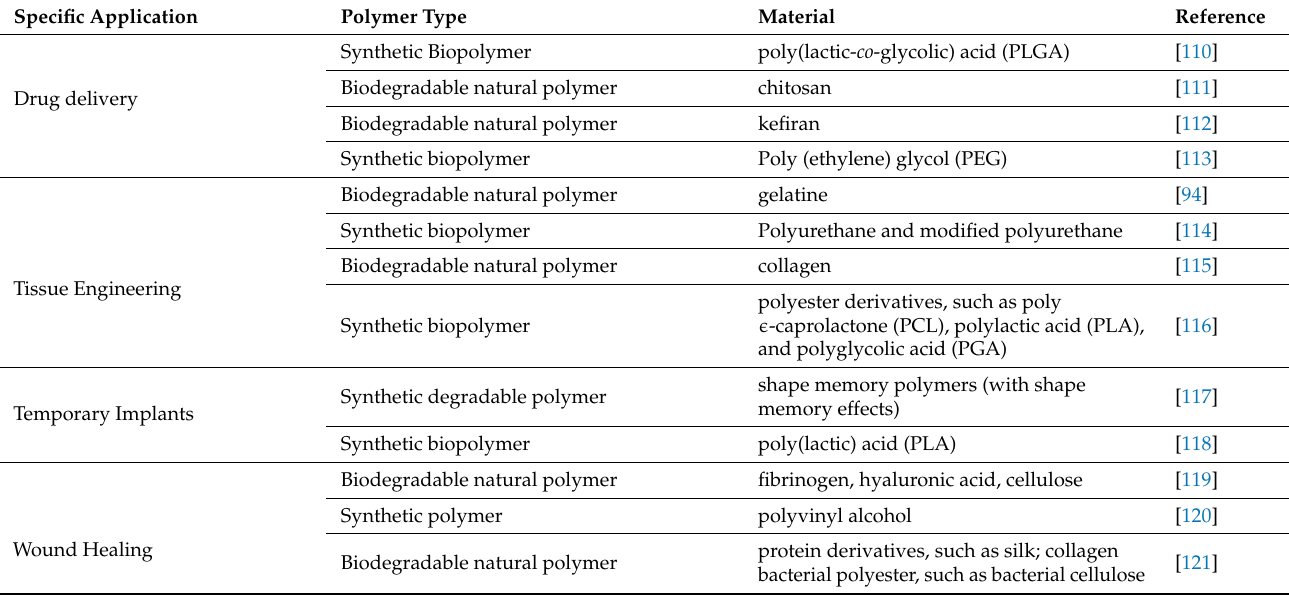
Table 4. Polymeric materials for biomedical